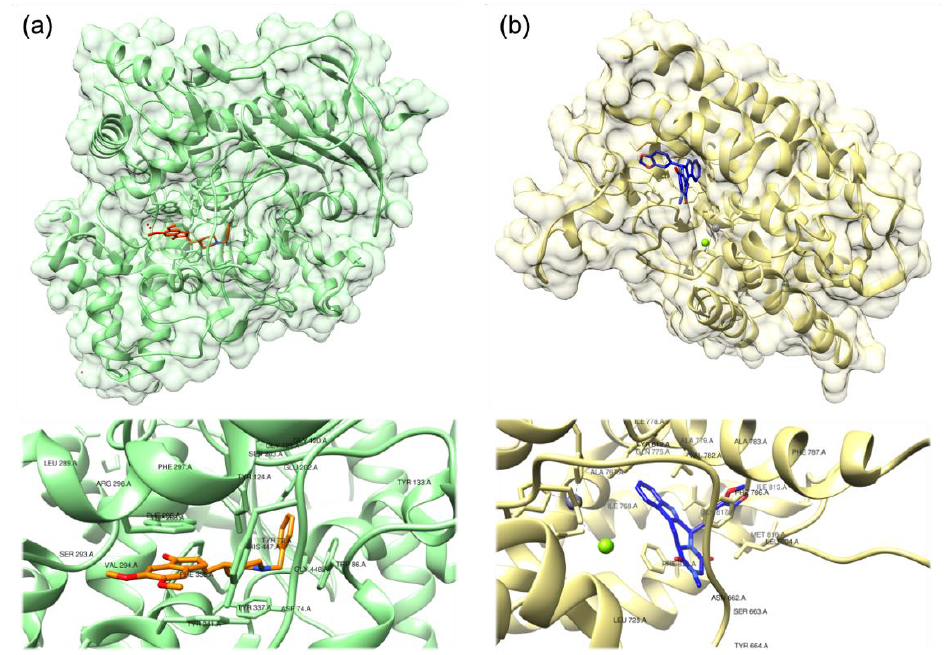
Figure 1. 3D structures of AChE in complex with donepezil ( a , PDB ID: 4EY7) and of PDE5 in complex with tadalafil ( b , PDB ID: 1UDU). In the artworks, the residues interacting with the ligands (<5 Å ) have been labeled.